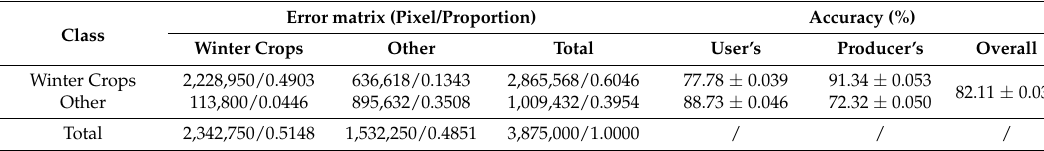
Table 4. Results of accuracy validation for MODIS